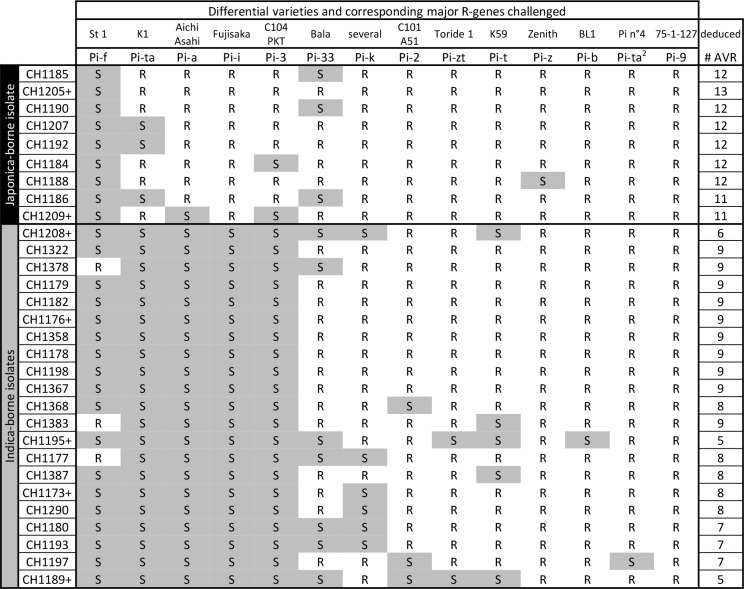
Estimation of Avr-Effector complement using rice differential lines in 30 selected isolates from Yuanyang (these isolates are indicated by a ‘*’ on Figure 1A showing neutral diversity).The Resistant (R) and susceptible (S) classes were established using the scale described in Figure 1—figure supplement 4. The isolates indicated with a ‘+’ were used for pathogenicity tests in Figure 4.